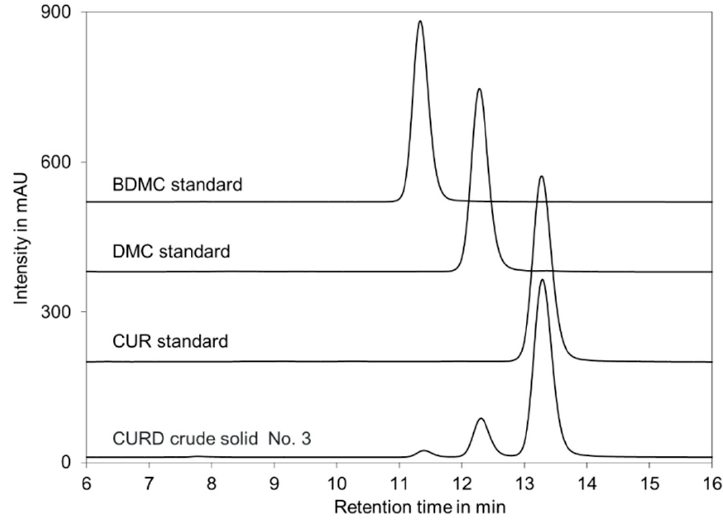
Figure 2. Analytical HPLC chromatograms of solid standards of BDMC, DMC, CUR and of the crude mixture No. 3 (see Table 1).